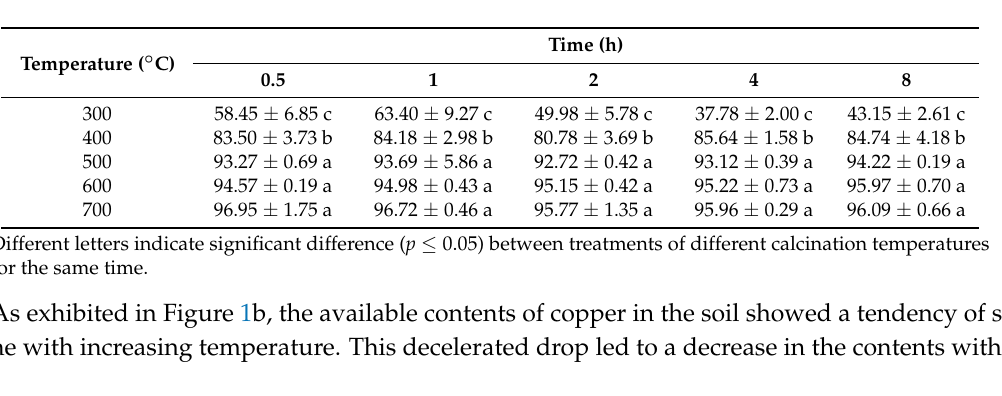
Table 2. The stabilization efficiency (%) of zinc in soils by calcination technique.